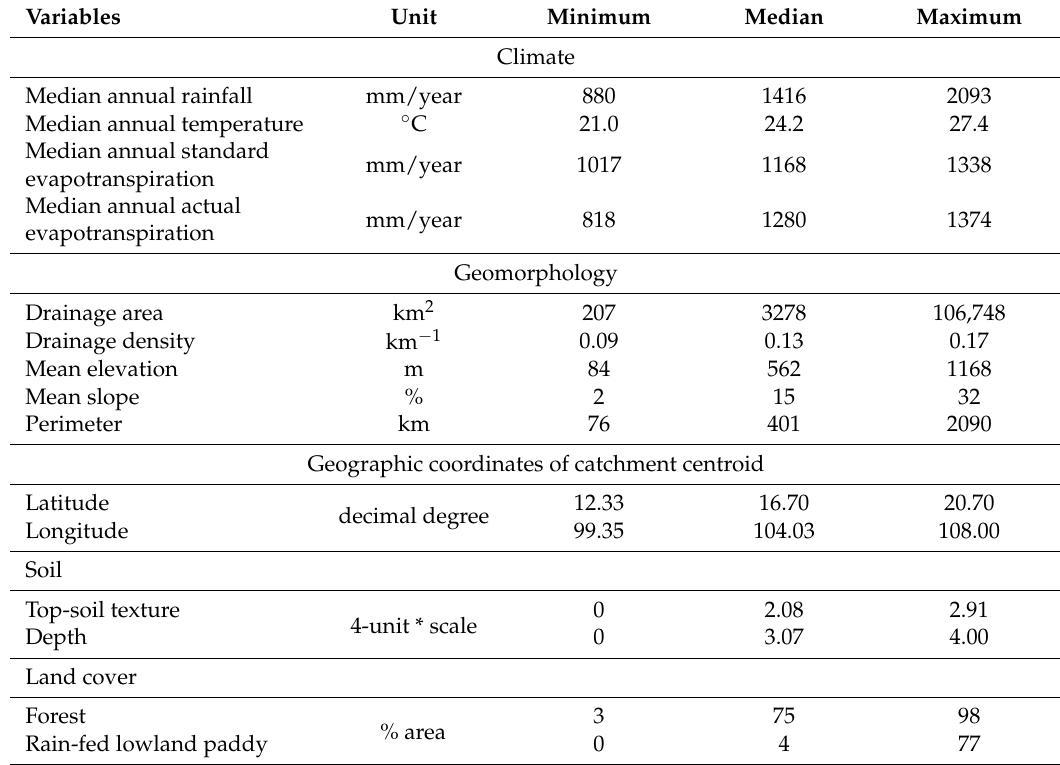
Table 1. Candidate explanatory variables considered in the multiple regression analyses: Variation ranges across the 65 catchments.